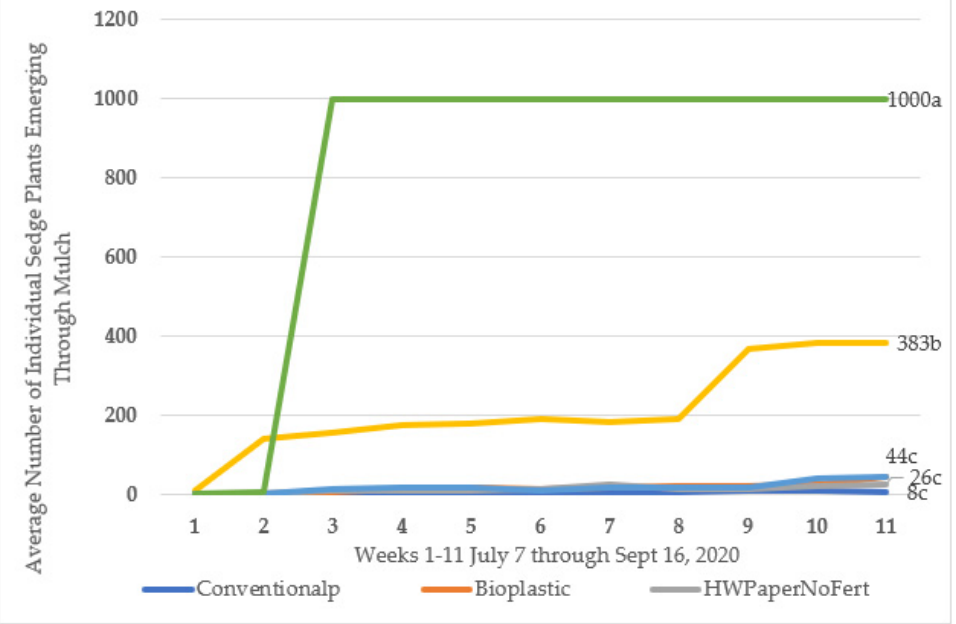
Figure 2. Individual sedge plants emerging through mulch treatments at the Baton Rouge, LA location. Mulch treatments with different letters are statistically significant at p ≤ 0.05 using SAS Proc GLM with Duncan. Untrt Control = un-mulched raised beds; Maize p = biodegradable maize plastic mulch; Bioplastic = biodegradable bioplastic mulch; Conventionalp = black polyethylene plastic mulch; HW Paper No Fert = heavy weight paper mulch without impregnated fertilizer; LW Paper Fert = light weight paper mulch with impregnated 3–3-3 fertilizer within the